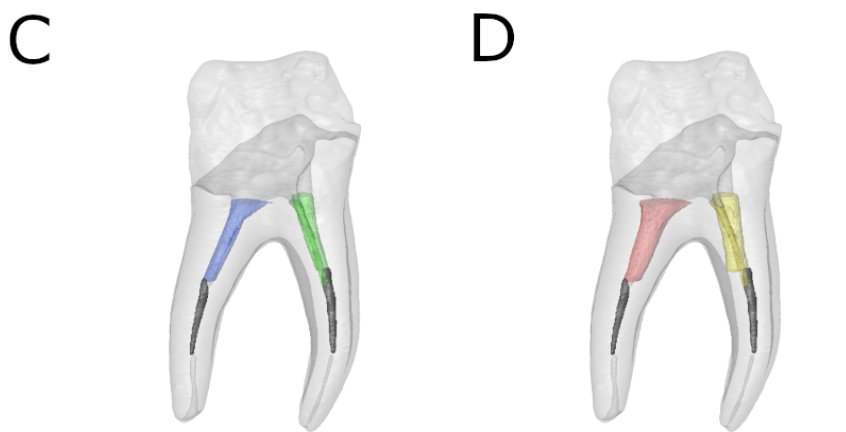
Figure 2. Reconstructed 3D micro-CT images of ( A ) preoperative and ( B ) postoperative ER study group and ( C ) preoperative and ( D ) postoperative US study group. Preoperative (blue) and postoperative (red) distal root canal and preoperative (green) and postoperative (yellow) mesial root canals were isolated. The fractured NiTi endodontic rotary files (black) were also isolated in both distal and mesiobuccal root canal systems.